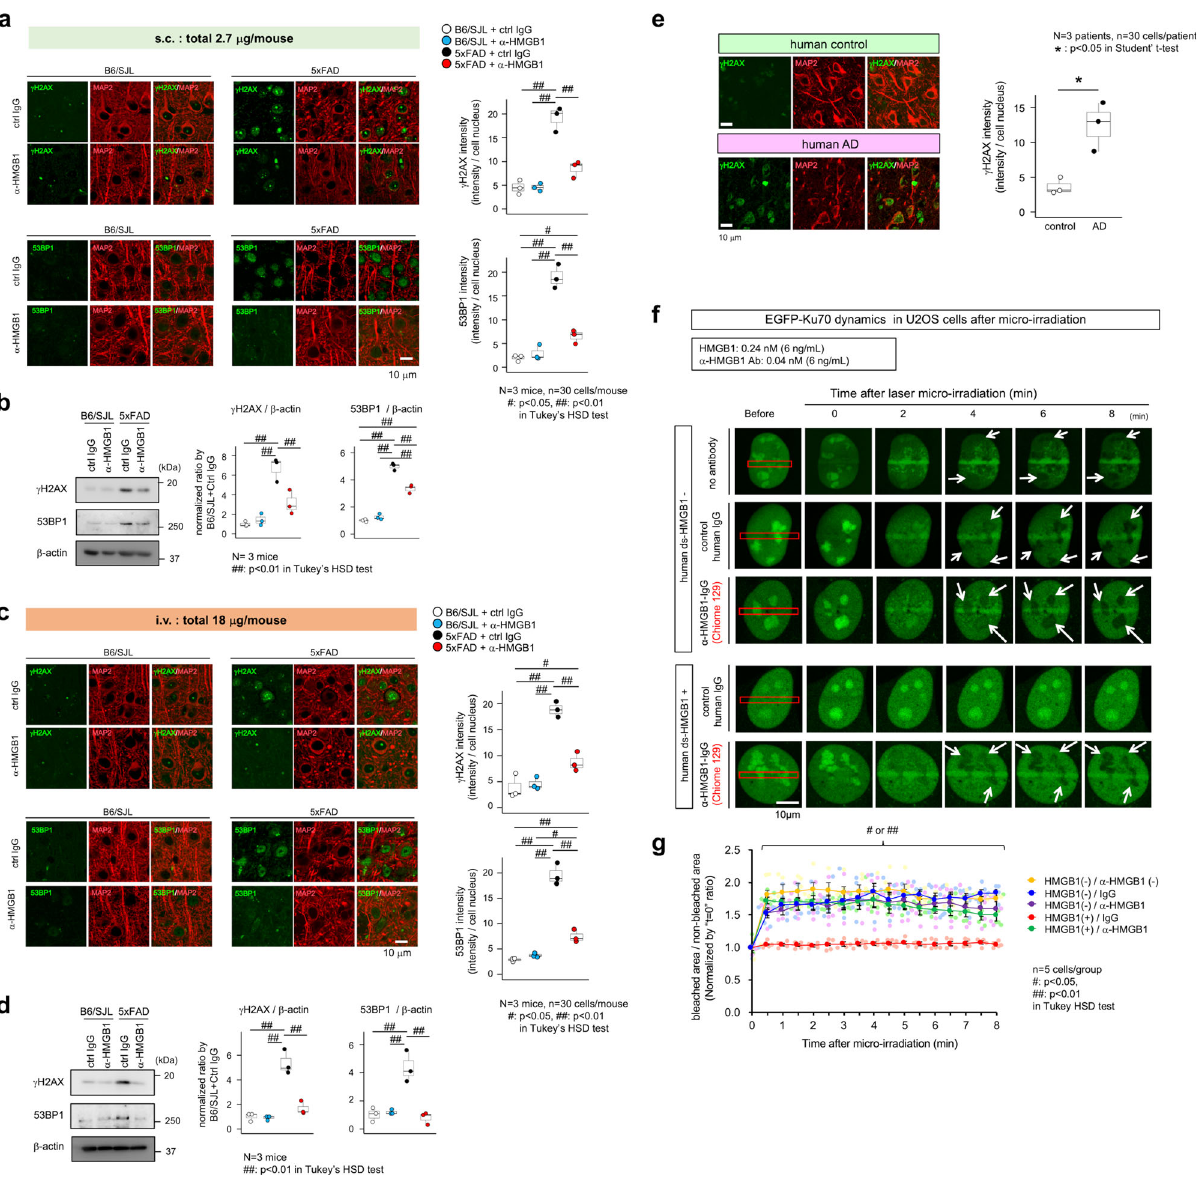
Fig. 3 Interruption of HMGB1 signal recovers neuronal DSB. a The abundance of DNA double-strand breaks was evaluated using two markers ( γ H2AX and 53BP1) in HMGB1 antibody-treated or control IgG-treated 5xFAD mice and non-transgenic sibling mice (B6/SJL). The graphs on the right show quanti fi cations of the intensity/nuclei for the four groups. N = 3 mice, n = 90 cells. Tukey ’ s HSD test revealed increased DNA damage in 5xFAD mice and a rescue via treatment with human monoclonal anti-HMGB1 antibody. b Western blot analysis of the entire cerebral cortices from the four groups with anti- γ H2AX and anti-53BP1 antibodies ( N = 3). c Immunohistochemical staining of γ H2AX and 53BP1 in occipital cortex neurons of 5xFAD mice that received subcutaneous or intravenous administration of human monoclonal anti-HMGB1 antibody (#129) or control human IgG. The graphs on the right show quantitative analyses of the γ H2AX and 53BP1 signals in MAP2-positive neurons. d Western blot analyses of γ H2AX and 53BP1 levels in whole cortex samples. e Immunohistochemical staining of human postmortem brain tissue samples (occipital lobe) from patients with no neurological diseases and AD patients with anti- γ H2AX antibody. f The dynamics of Ku70 recruitment to DNA damage foci induced via microirradiation were evaluated by transiently expressing EGFP-Ku70 in U2OS cells cultured in the presence/absence of HMGB1 (0.24 nM). Human monoclonal anti-HMGB1 antibody (#129) but not control human IgG or mock treatment rescued the delayed EGFP-Ku70 accumulation at DNA damage foci. g Quantitative analyses of the EGFP-Ku70 intensities at damage sites from time-lapse images of U2OS cells ( n = 5) from which the EGFP-Ku70 intensities from a non-damaged area of the nucleoplasm were subtracted. The rate of EGFP-Ku70 accumulation was reduced in the presence of HMGB1 but recovered upon co-addition of human anti- HMGB1 monoclonal antibody to the culture medium. Values in each group are summarized by mean ± SEM. Box plots show the median, quartiles, and whiskers that represent data outside 25th to 75th percentile